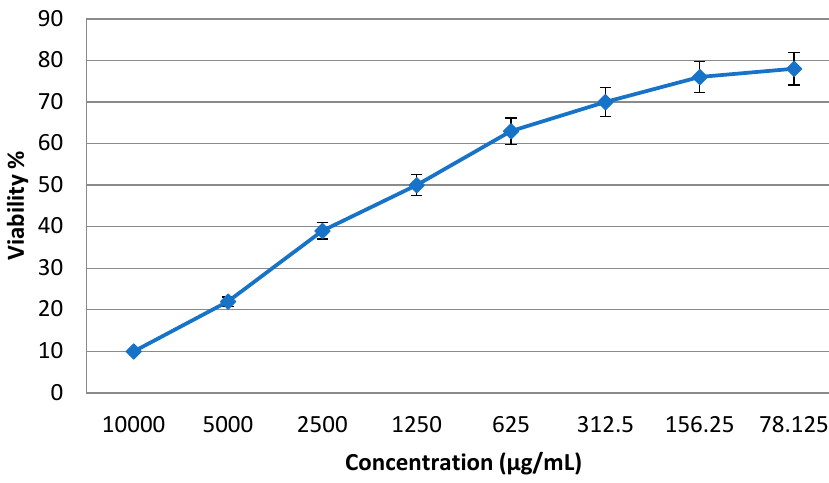
Figure 4. The cytotoxic effect of the prepared γ -Al 2 O 3 -NPs.